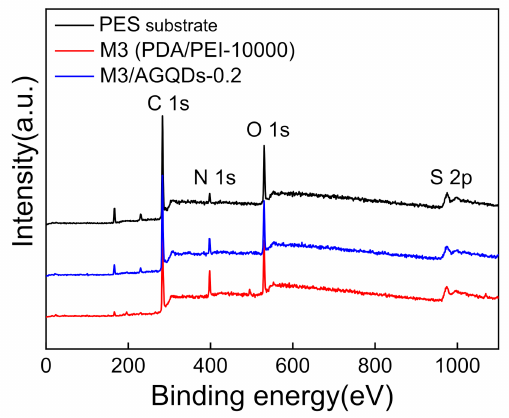
Figure 6. XPS full spectra of PES substrate and NF membranes. Table 2. The chemical compositions of PES substrate and NF membranes by